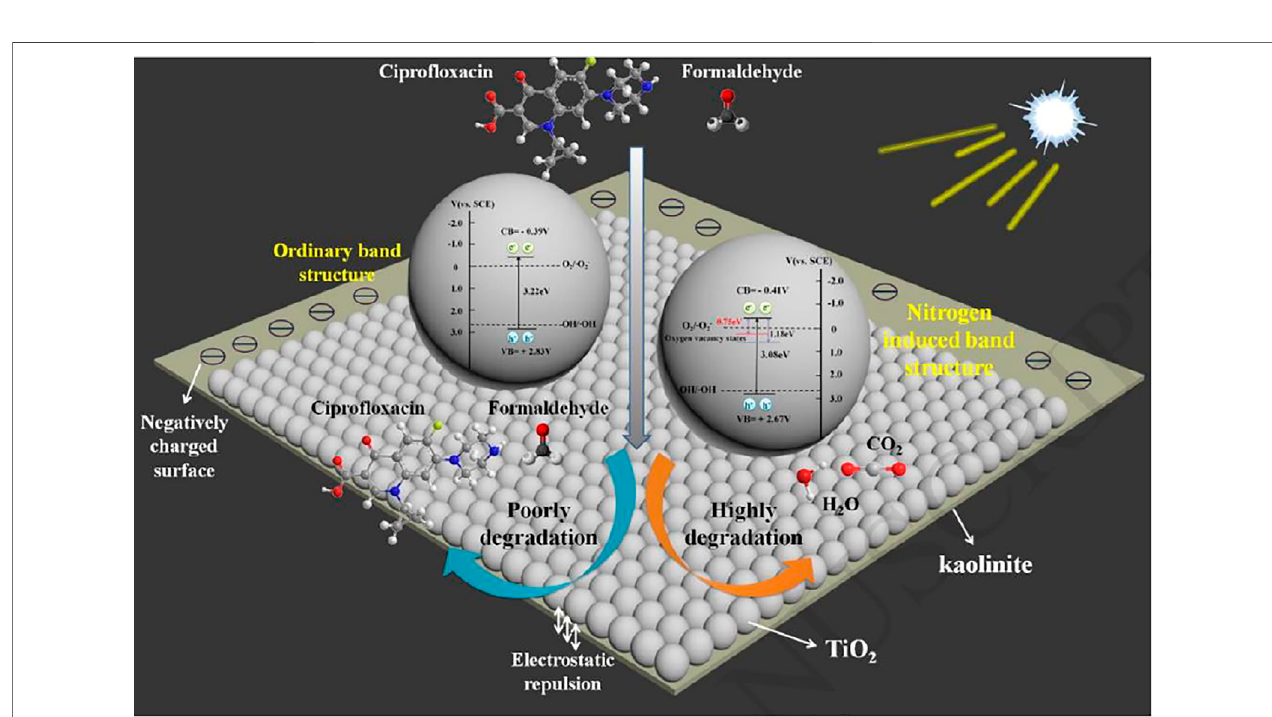
FIGURE 3 | The diagram description of the photocatalytic degradation enhancement mechanism of TiO 2 /kaolinite composite (Li et al.,2018b).